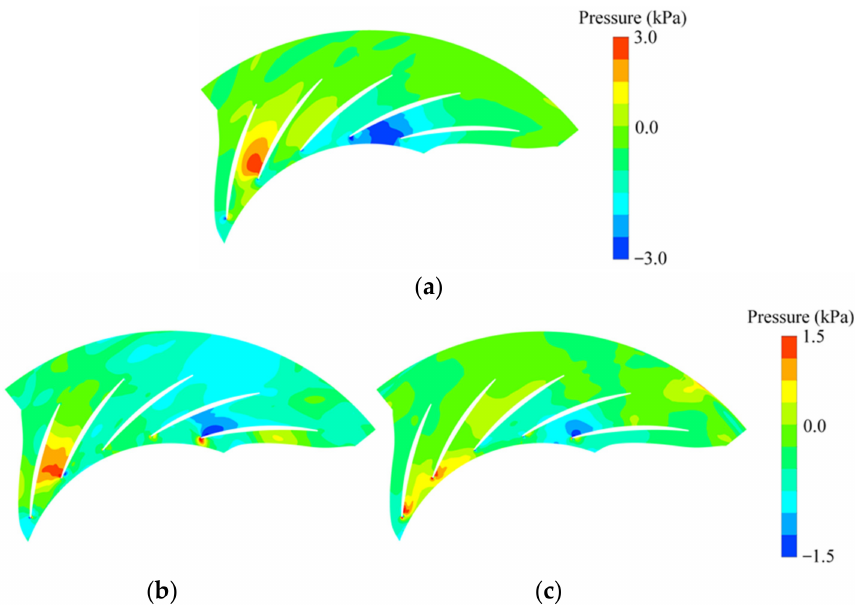
Figure 17. Spatial distribution of the pressure field for DMD modes of the low frequency (97% span, ϕ = 0.0833): ( a ) IGV30; ( b ) IGV45; ( c )